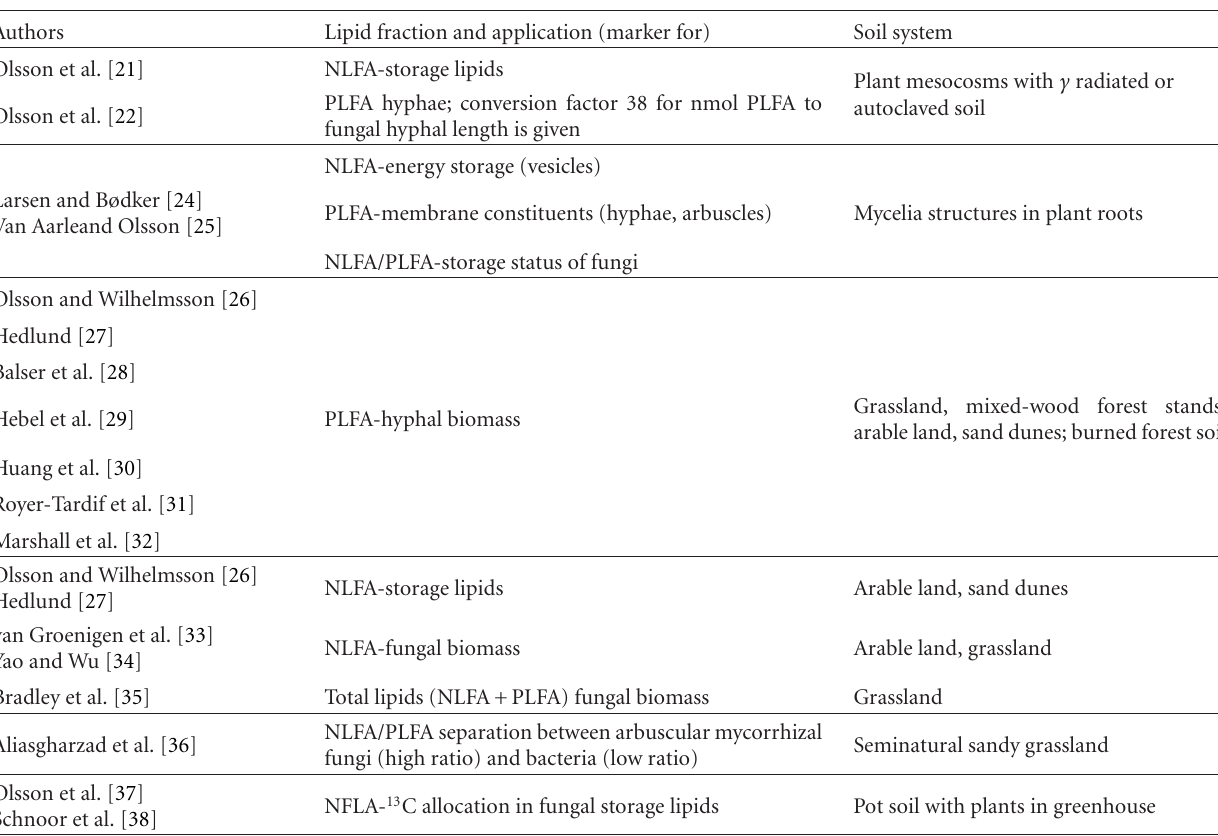
Table 1: Application of the marker fatty acid 16:1 ω 5 to assess the distribution of arbuscular mycorrhiza fungi in artificial and natural